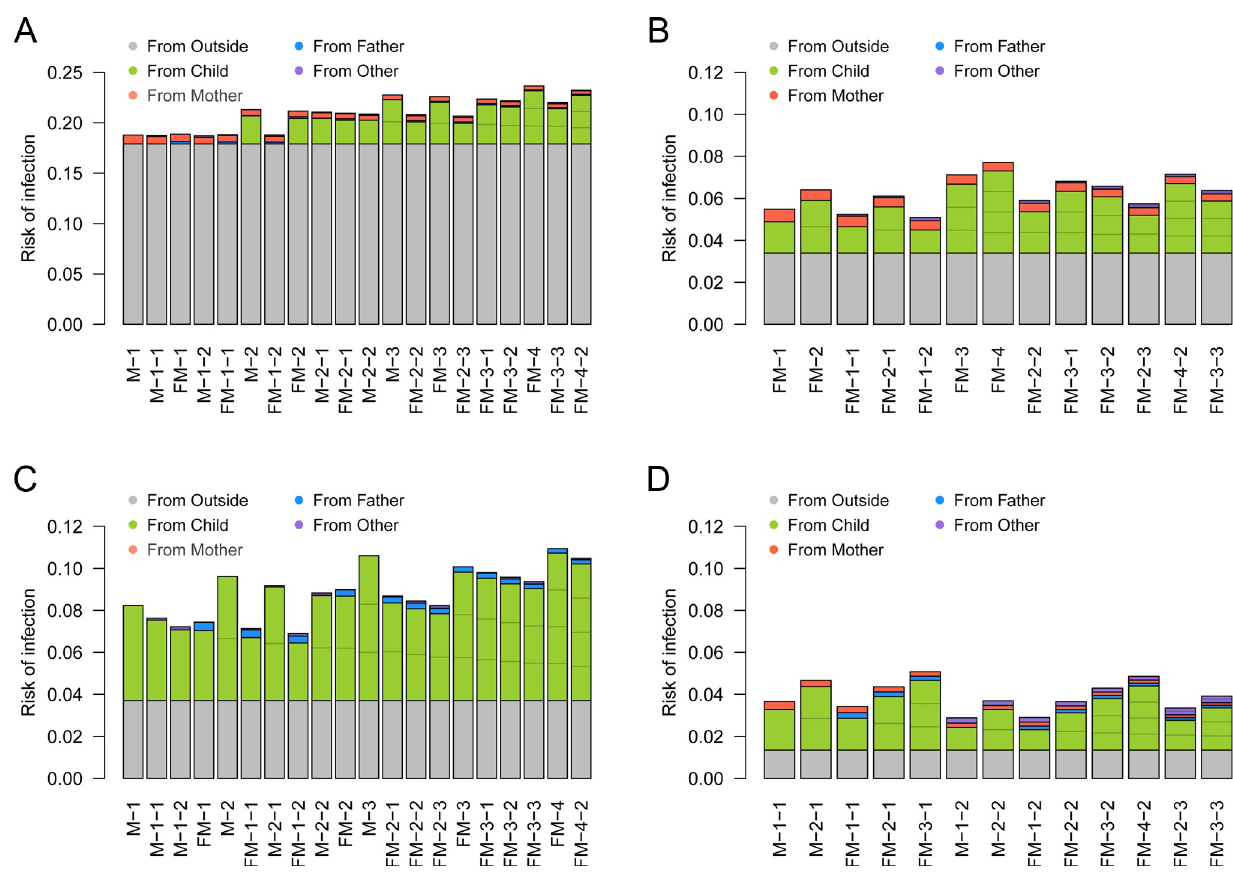
Fig 5. The risk of primary/secondary infection to individuals in different household compositions and its source. (A) Child; (B) Father; (C) Mother; (D) Other. The coloured compartments denote the breakdown of sources. Household compositions are displayed in the same order as Fig 4. The risk of primary infection in children was set to be 16.4%, the average between those of “students” and “siblings”. Note that the scale of the y-axis in (A) is different from the other three panels.